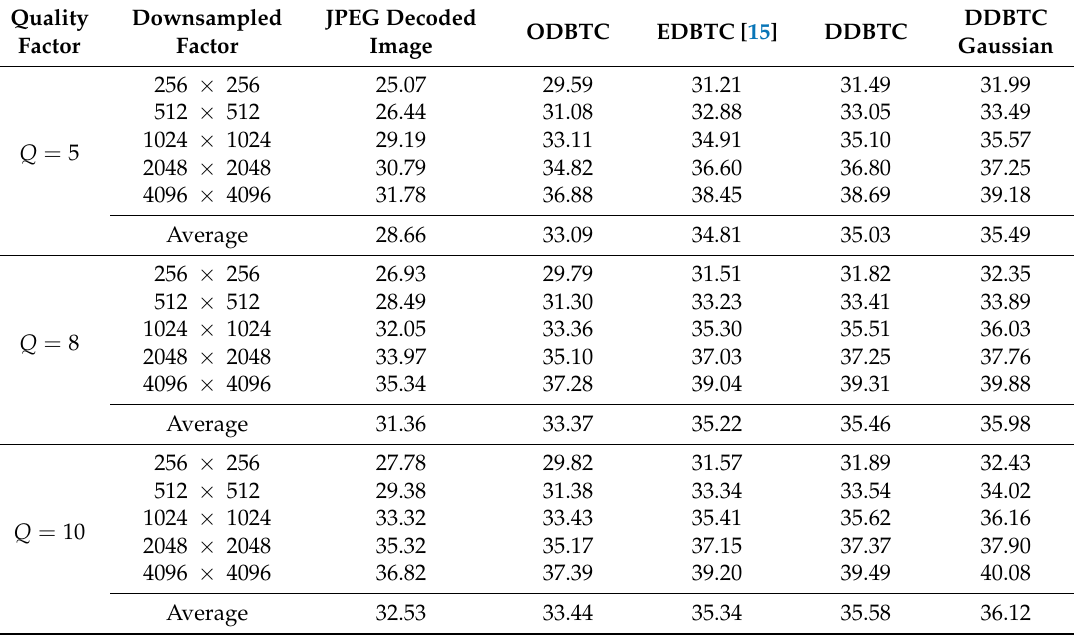
Table 2. PSNR Comparison on Image Set 1.